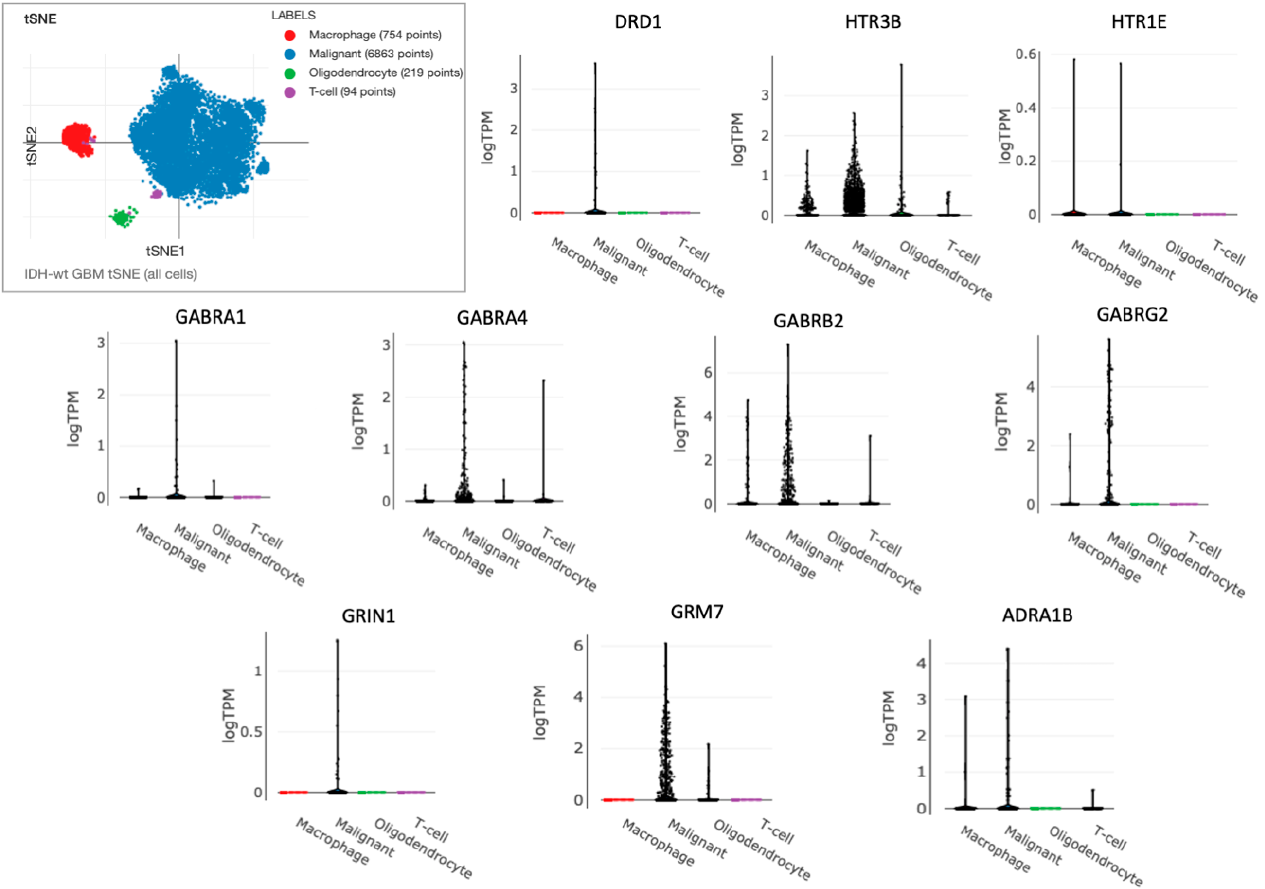
Figure 5. Single-cell gene expression levels of the 10-NTR genes in GBM. The single-cell RNA-seq GBM dataset (GEO accession number GSE131928) was accessed using the Single Cell Portal (https://singlecell.broadinstitute.org/single_cell, accessed on 20 April 2021). In the upper corner, the t-distributed stochastic neighbor embedding (tSNE) plot of all single cells from 28 glioblastomas is shown. Four clusters were identified which were associated with the high expression of markers for malignant cells and three non-malignant cell types. The violin plots show the single-cell gene expression levels for each cell